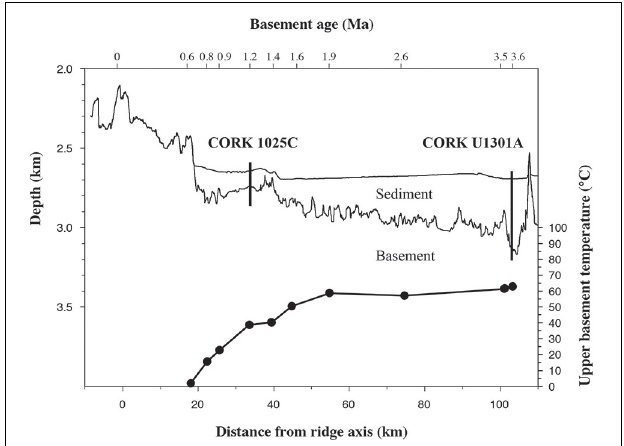
FIGURE 2 | Sulfate reduction rates, determined from temperature-gradient experiments after 3 and 5 days of incubation of unamended crustal fluids collected from boreholes 1025C and U1301A, respectively. Full circles represent the average of two experimental replicates. The range between maximum and minimum measurements is shaded in